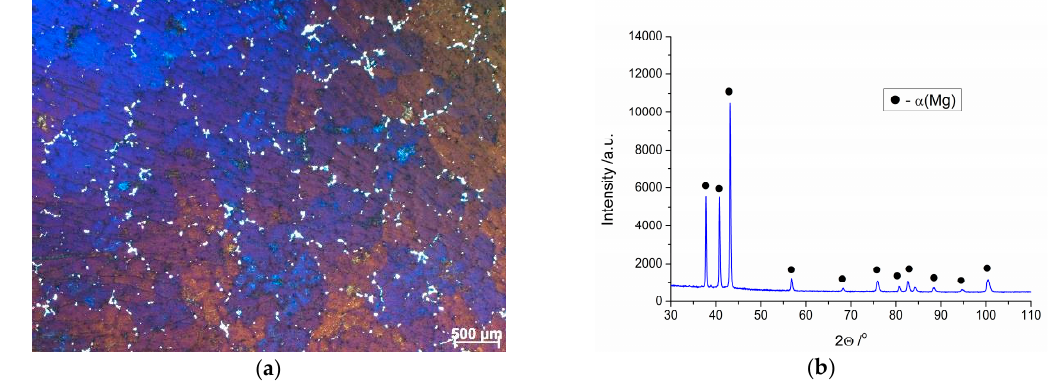
Figure 2. ( a ) LOM image and ( b ) XRD pattern of the as-cast Mg–4.5 Li–1.5 Al + 0.2 TiB alloy. The true stress–strain curves of the Mg–4.5 Li–1.5 Al + 0.2 TiB alloy in different conditions are